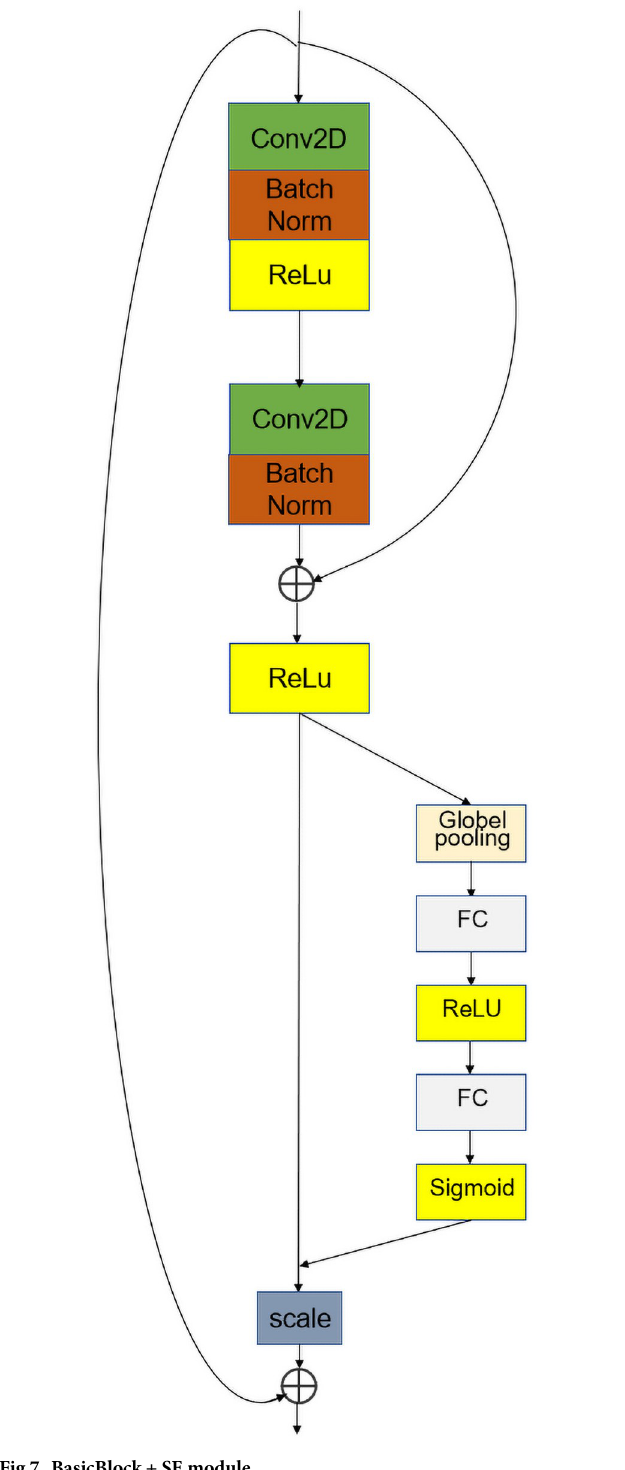
Fig 7. BasicBlock + SE